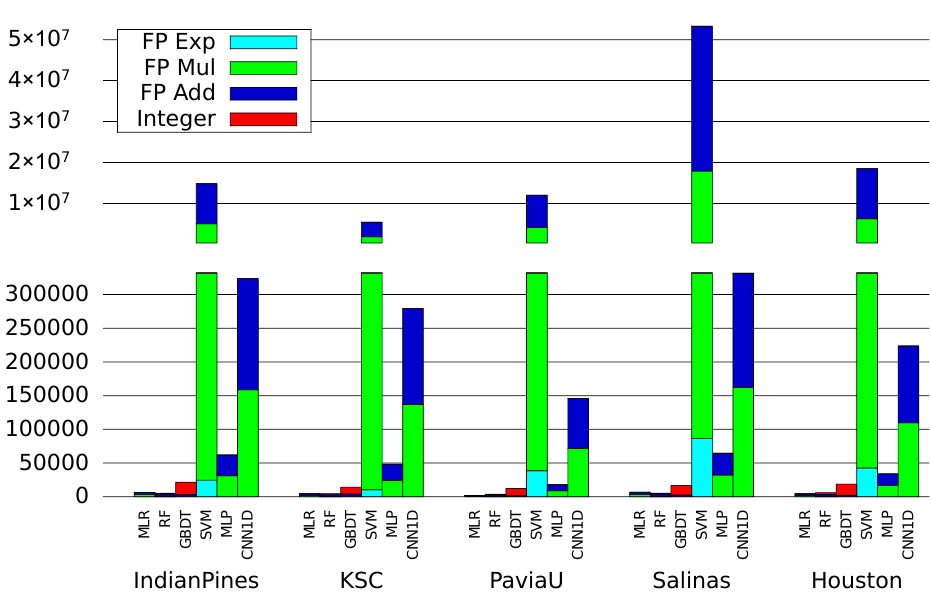
Figure 6. Number of operations performed during the inference